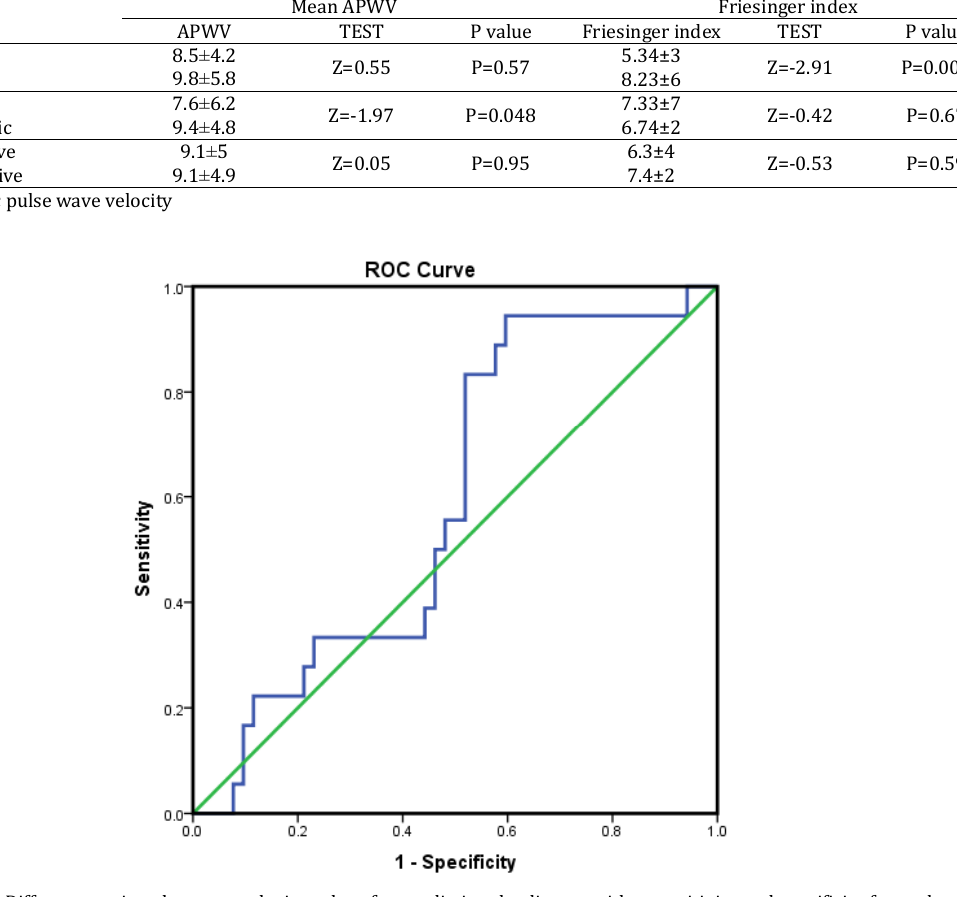
Figure 2 . Different aortic pulse wave velocity values for predicting the disease with a sensitivity and specificity for each